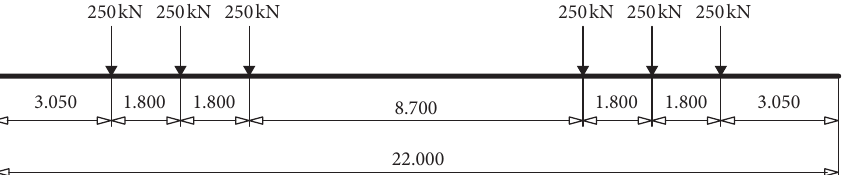
Figure 6: Load diagram of DF8B locomotive.